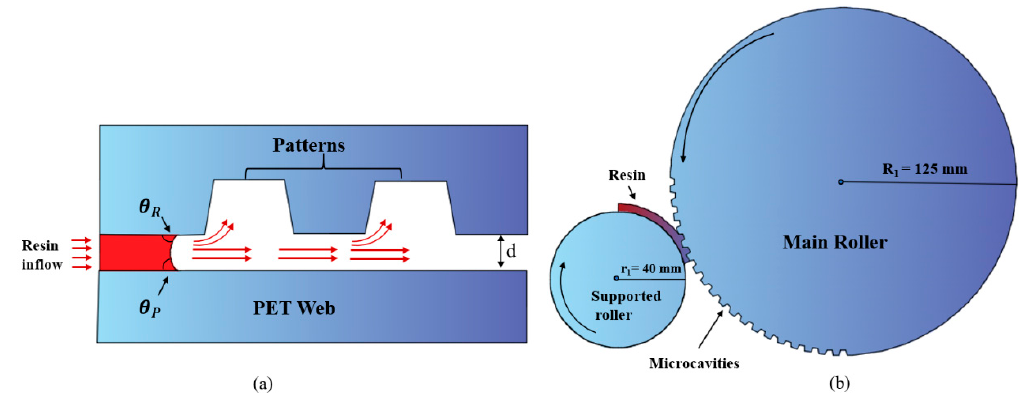
Figure 1. ( a ) Microcavity filling with ultraviolet (UV) resin between two parallel plates and contact angle of resin with stamp roller and polyethylene terephthalate (PET) web; ( b ) microcavity filling in the domain of the third quadrant in the roll-to-roll imprinting process.